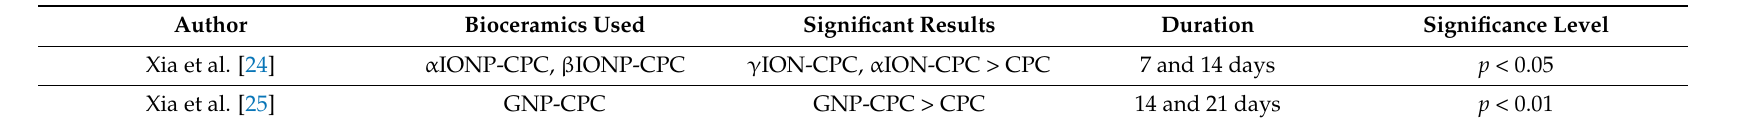
Table 12. Summary of the results of included studies showing significant differences between a bioceramic material with an additive and the bioceramic material itself for ARS staining.